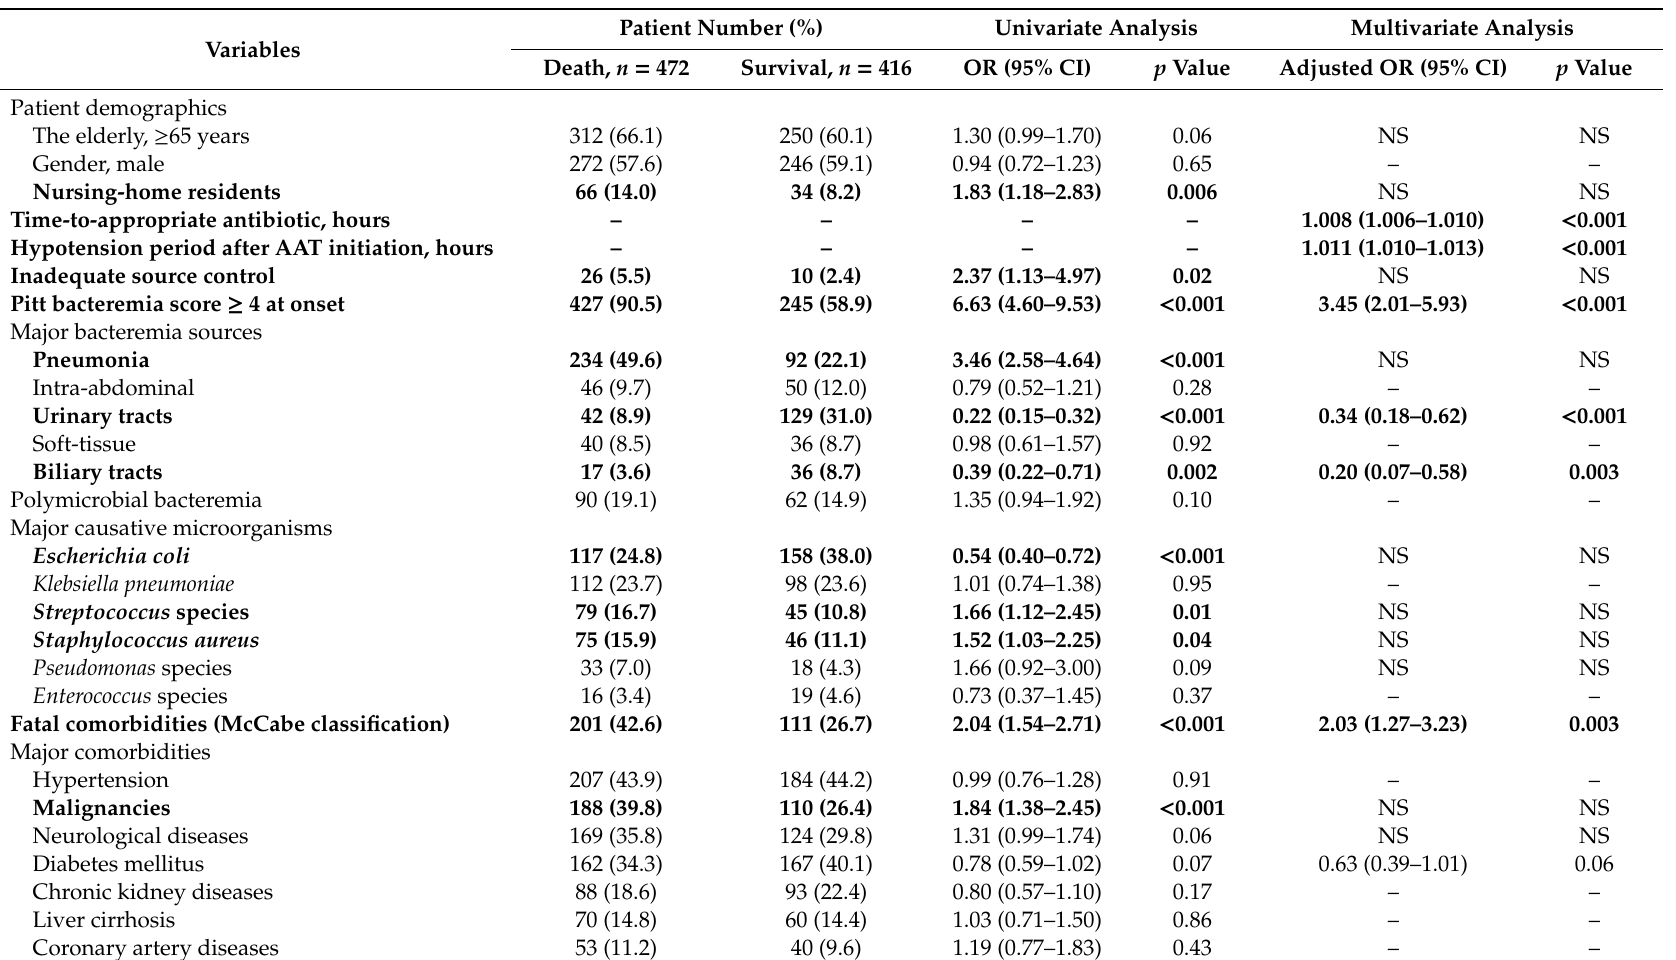
Table 1. Predictors of 30-day crude mortality in patients having community-onset bacteremia and initially presenting with severe sepsis and septic